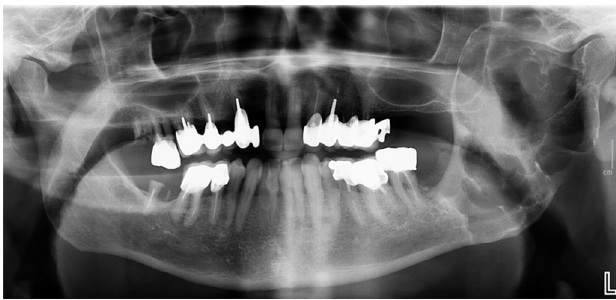
Fig. 2. Panoramic radiography showing diffuse osteolysis of the ascending branch of the left mandible 5 years after the fi rst consultation.